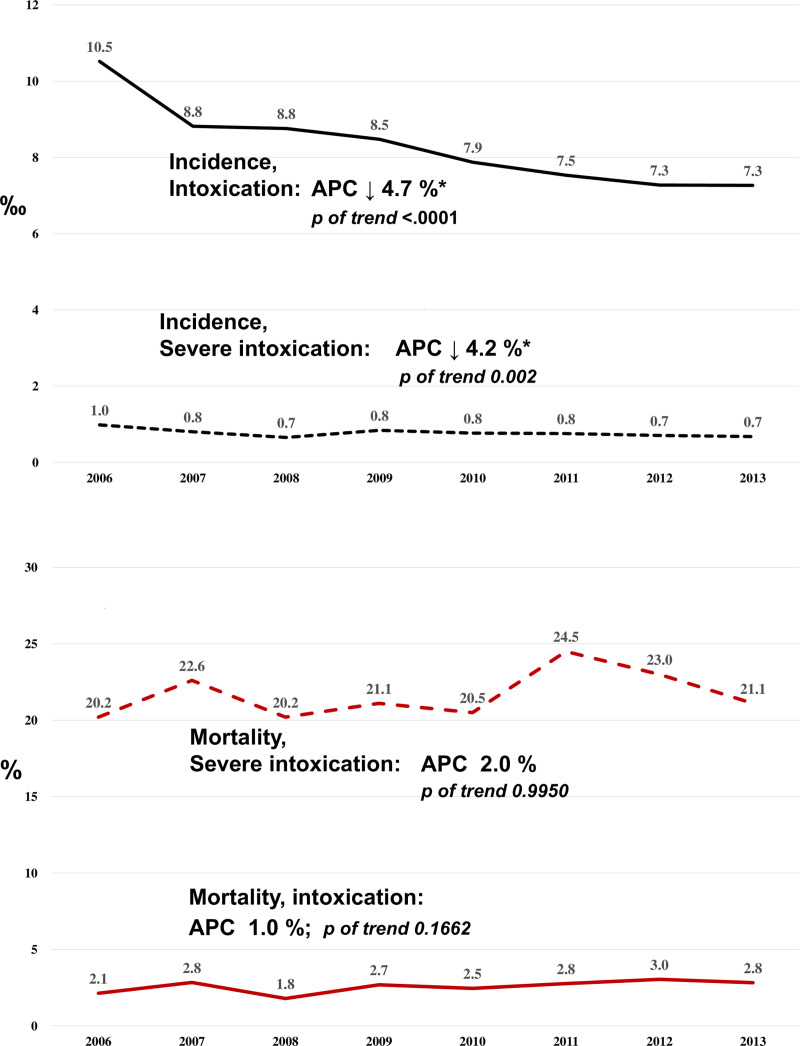
A. Trend of Incidence in intoxicated and severe intoxicated patients. Both the incidence of intoxicated events, and the incidence of severe intoxicated events were decreasing over times. The APC were decreased 4.7% in the incidence of intoxicated events, and 4.2% in the severe intoxicated. Abbreviations: APC: annual percentage change; B. Trend of the mortality in intoxicated and severe intoxicated patients. There was no significant trend change of mortality in both the intoxicated or severe intoxicated events.